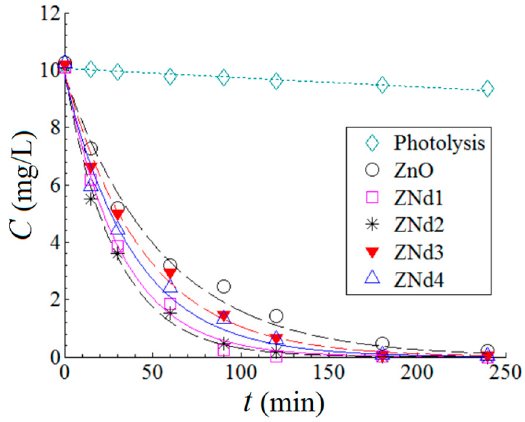
Figure 7. Kinetics of MB dye photodegradation in aqueous solutions under visible light irradiation and in the presence of the produced catalysts (ZnO and ZnO:Nd); solid and dash lines provide pre- dictions according to pseudo-first-order kinetic model; experimental conditions: catalyst dosage = 1 g/L; T = 23 ± 2 ◦ C; pH 7.0 ±